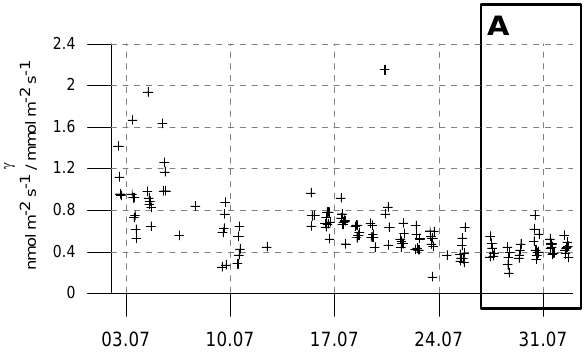
> 4mmolm − 2 s − 1 ) of the 2 O